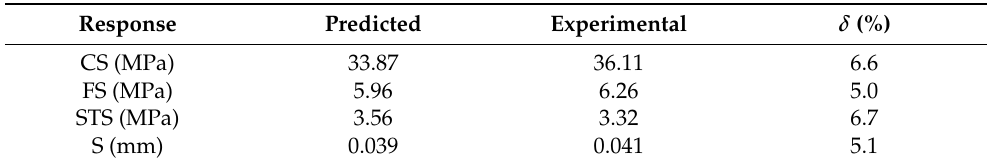
Table 6. Experimental validation and percentage error.